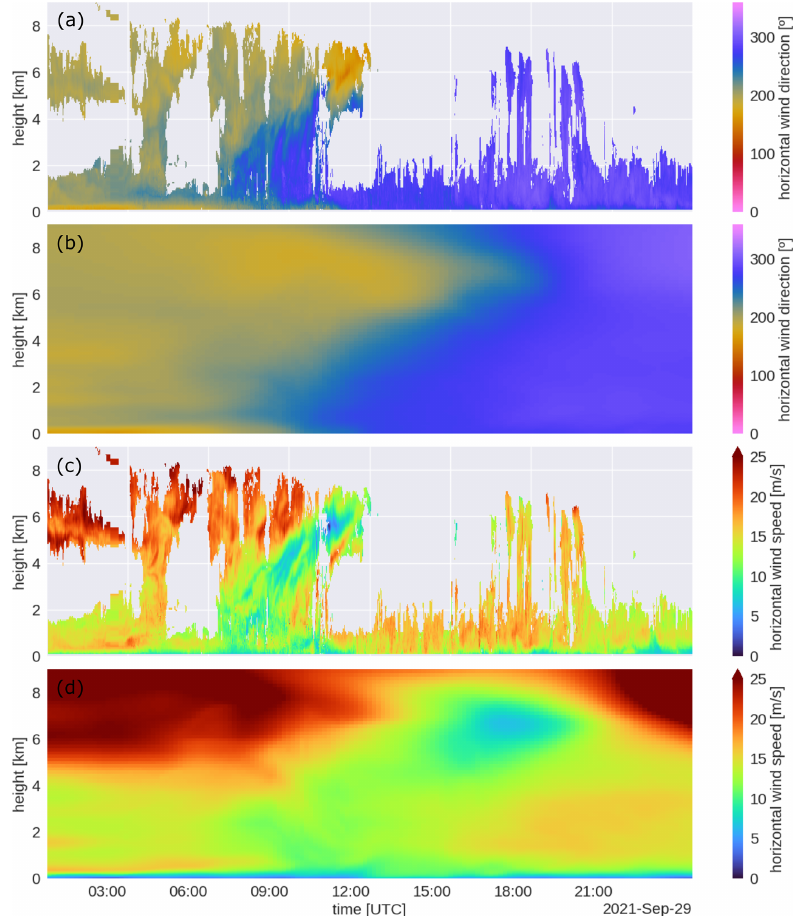
Figure 15. Time–height plot of wind direction (panels a and b ) and speed (panels c and d ) from the CMTRACE level 2 (panels a and c ) and from DALES (panels b and d ) from 29 September